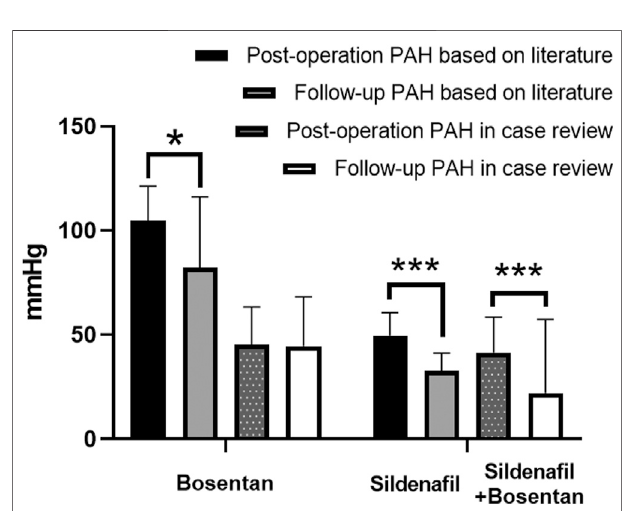
FIGURE6| Comparisonofpostoperativepulmonarypressurereduction effects between bosentan and sildena fi l in case review and literature. * p < 0.05; ** p < 0.01; *** p <